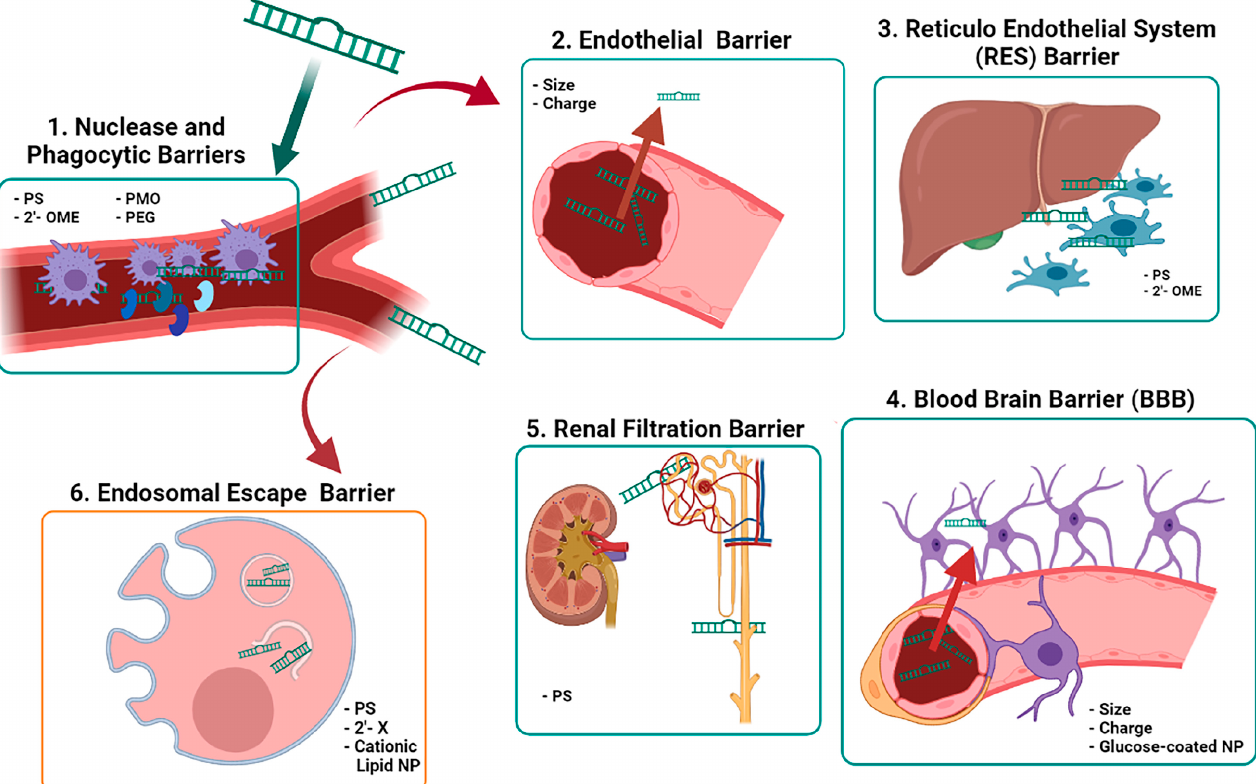
Figure 1. Extracellular and intracellular barriers for therapeutic ncRNAs action. The diagram shows systemic delivery and metabolism of therapeutic ncRNAs ( 1 , 2 , 3 , 4 , 5 ), as well as intracellular uptake ( 6 ). Chemical modifications and improvements to avoid nuclease degradation are listed inside the frame as hyphens and small letters. Abbreviations: 2’-X: general modification at 2’; 2’-OME: 2’-O-methyl; PS: phosphorotioate; PMO: phosphorodiamidate morpholino oligomers; PEG: pegylation; NP: nanoparticles. * Image created with BioRender.com.